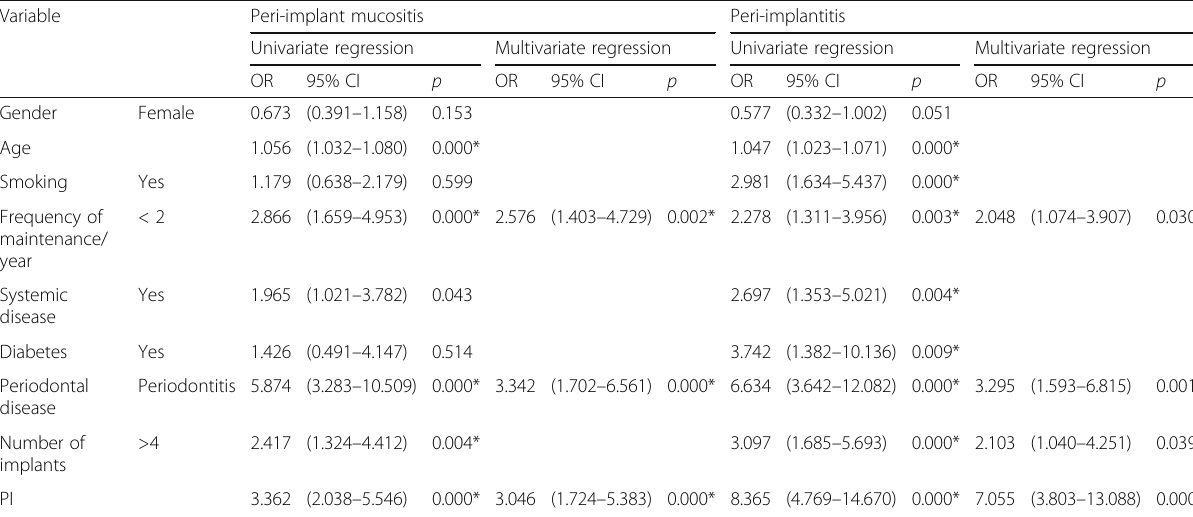
Table 4 Patient-related probable risk indicators for the occurrence of peri-implant mucositis and peri-implantitis